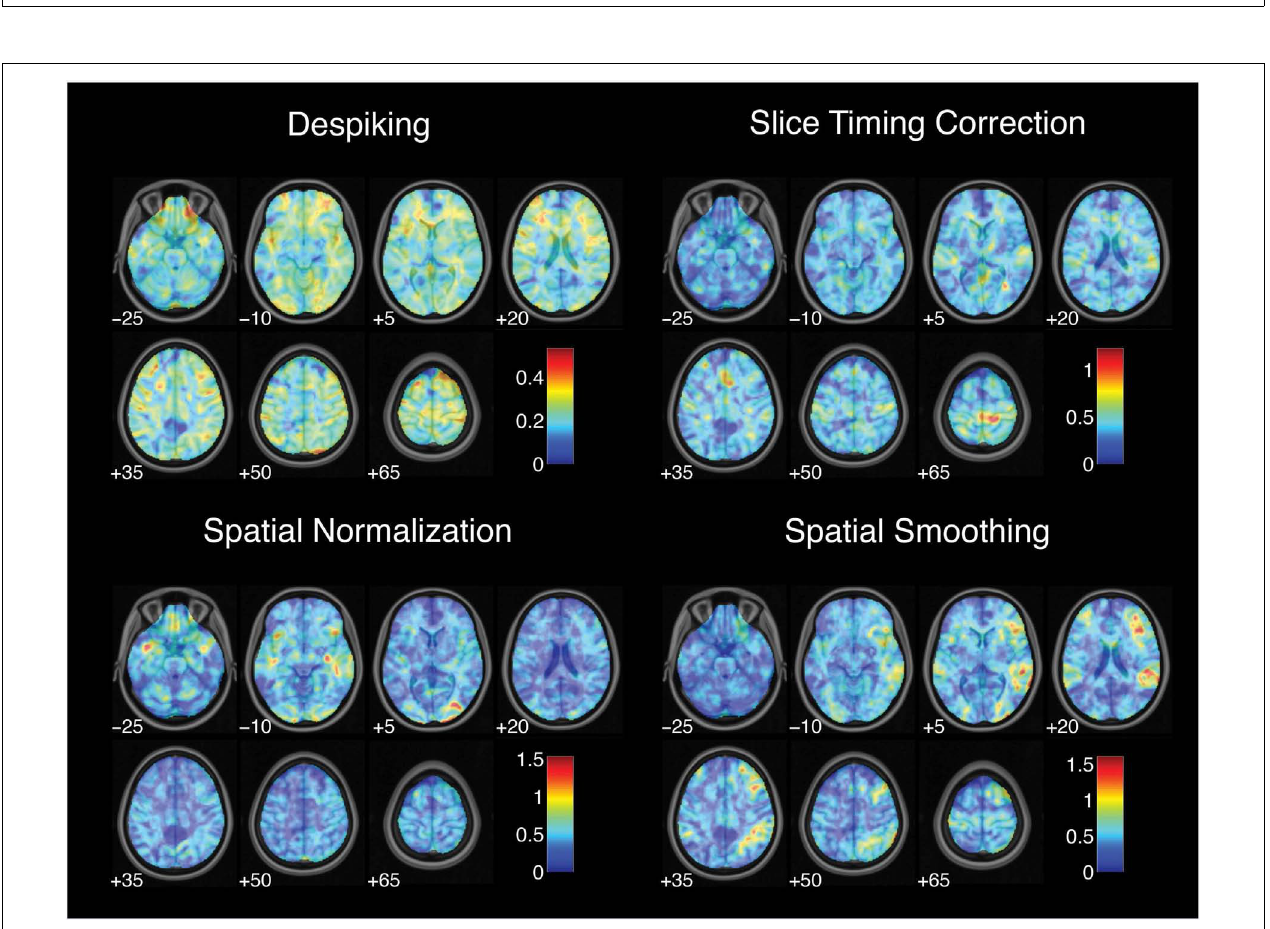
FIGURE 1 |Variation in activation strength across analysis pipelines. Mean activation denotes the average Z -value for each voxel across all analysis pipelines; analysis range denotes the range of Z -values across all